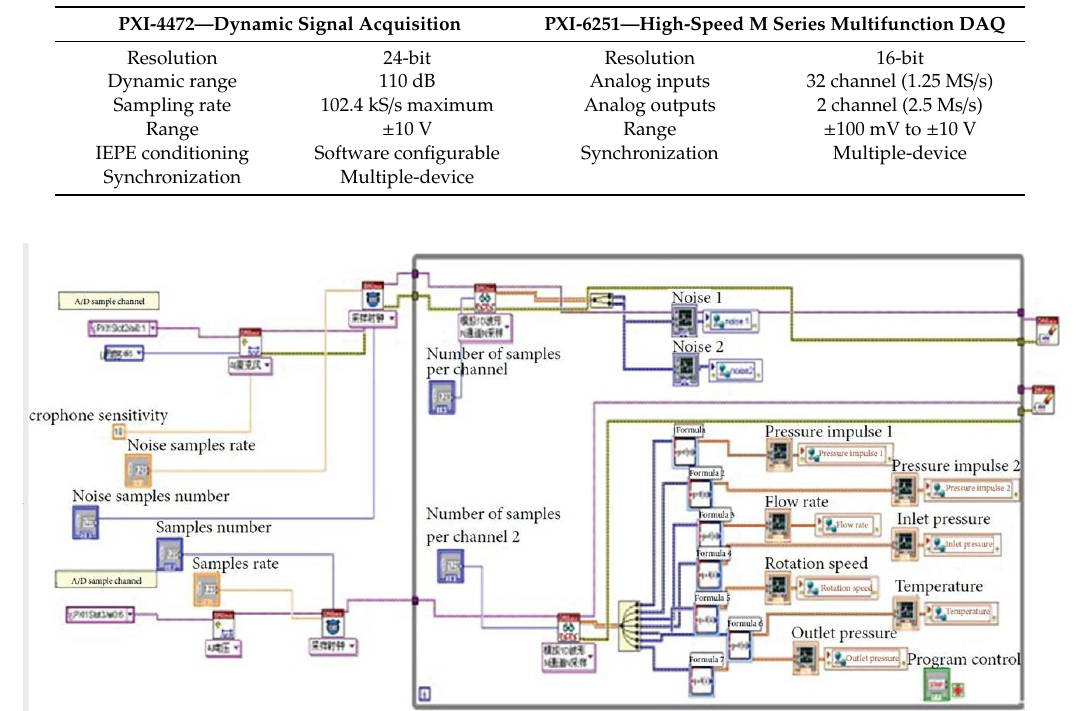
Figure 5. Software composition of the dynamic signal acquisition card.